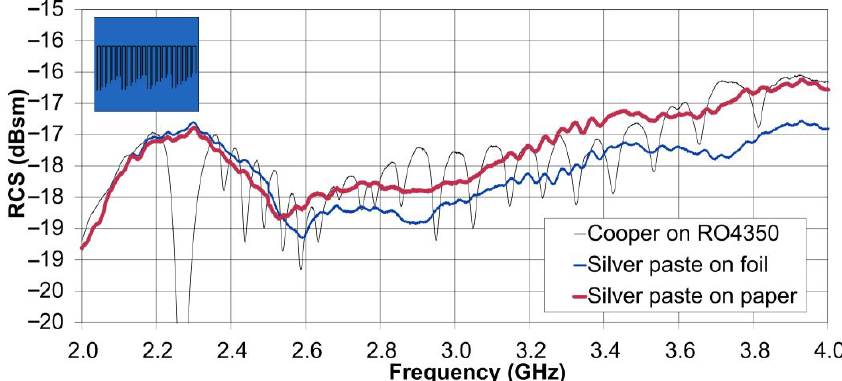
Figure 14. Measured RCS of re-arranged U-slots in the metallic plate tag manufactured by the screen-printing technology on Folanorm polyester film and a paper substrate compared to a standard copper-on-microwave substrate technology.